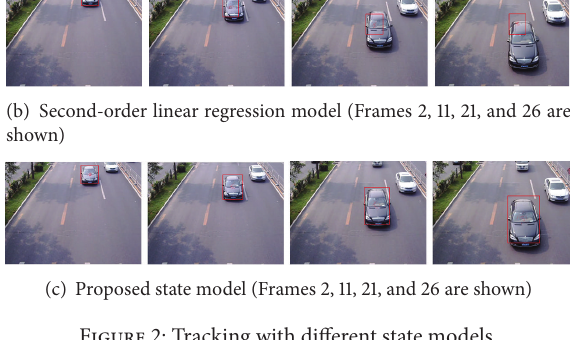
Figure 2: Tracking with different state models.